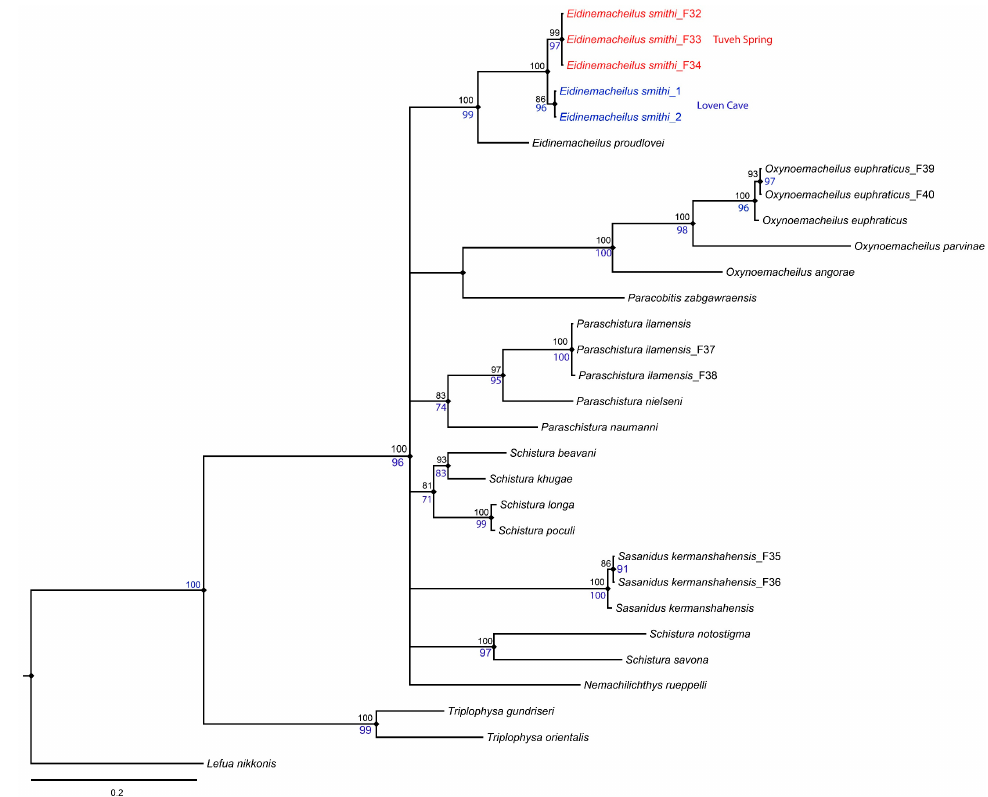
Figure 3. Bayesian and Maximum-Likelihood phylogeny reconstructed based on 582 bp of COI. The values show BI posterior probability (black) and maximum-likelihood (ML; blue) node supports. The topology is from the maximum-likelihood analysis. The values less than 60% are not shown.